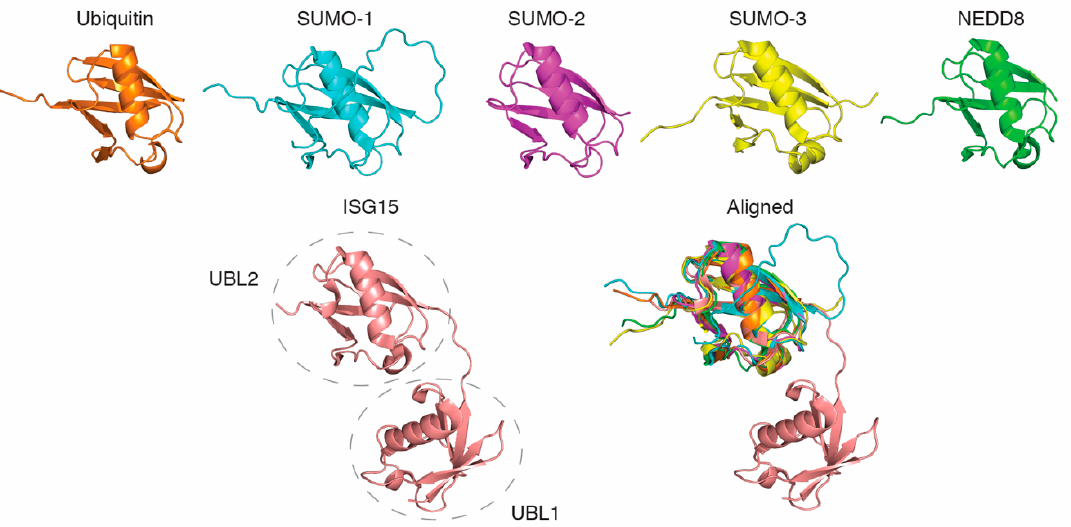
Figure 2. All ubiquitin-like proteins contain one or more structurally near-identical ubiquitin-like folds. The figure represents the individual and aligned structures of ubiquitin (PDB 1ubq), NEDD8 (PDB 2ko3), SUMO-1 (PDB 2n1v), SUMO-2 (PDB 1WM3), SUMO-3 (PDB 1u4a), and ISG15 (PDB 1Z2M). The dashed circles indicate the two ubiquitin-like domains (UBL1 and UBL2) of ISG15.